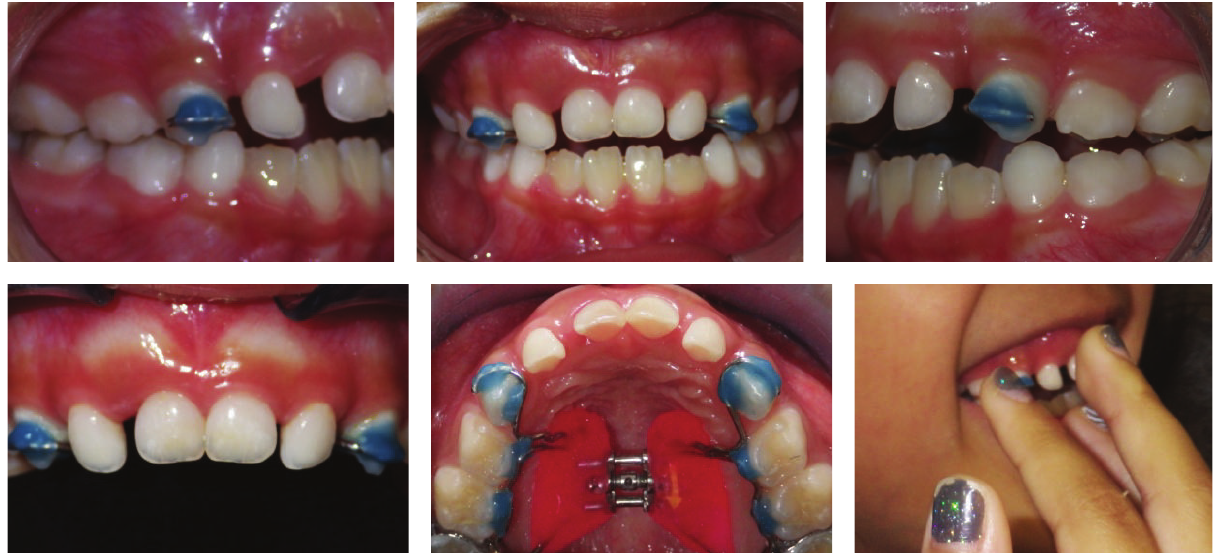
Figure 3: Progress after 3 weeks of palatal expansion. The appliance work as “reminder” and serve to curb the habit.